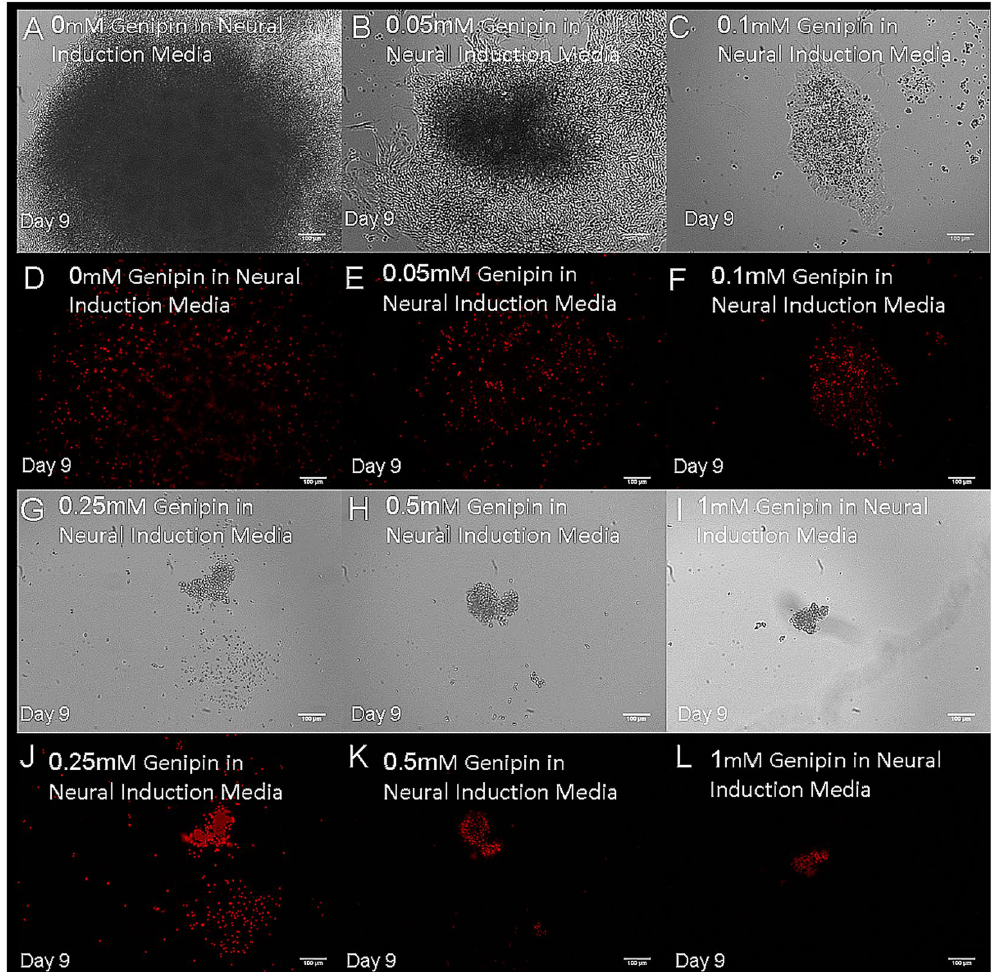
Figure 1. High concentrations of genipin induce death of hiPSC-derived neural progenitors. Images show cell cultures after 9 days of exposure to the following concentrations of genipin: ( A and D ) 0 mM, ( B and E ) 0.05 mM, ( C and F ) 0.1 mM, ( G and J ) 0.25 mM, ( H and K ) 0.5 mM and ( I and L ) 1 mM in phase contrast and fluorescence respectively. Each image represents a single neural aggregate with an initial seeding density of 4000 cells/aggregate (biological n = 3, technical n = 3).